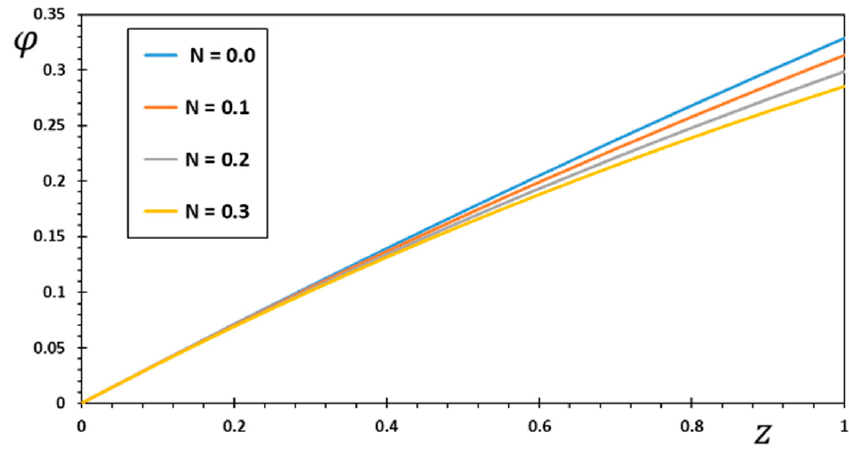
Figure 4. Variation of electric potential 𝜑 for various values of the gradient coefficient 𝑁 .